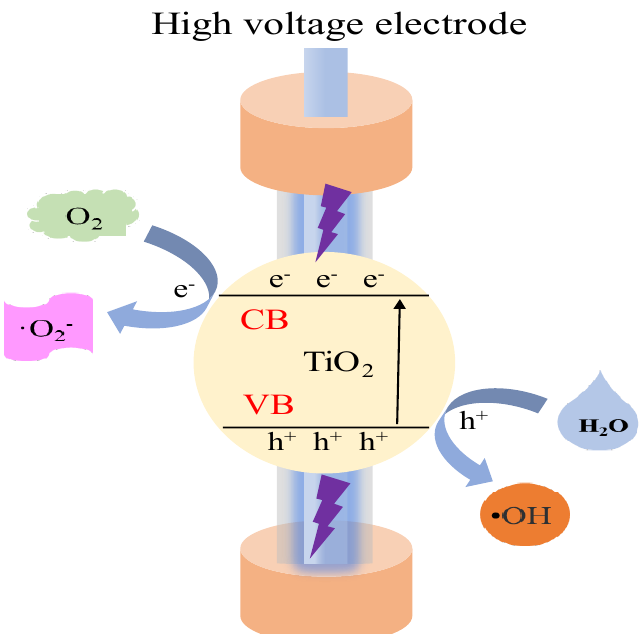
Figure 5. Mechanism of DBD coupled with TiO 2 for the degradation of organic pollutants.